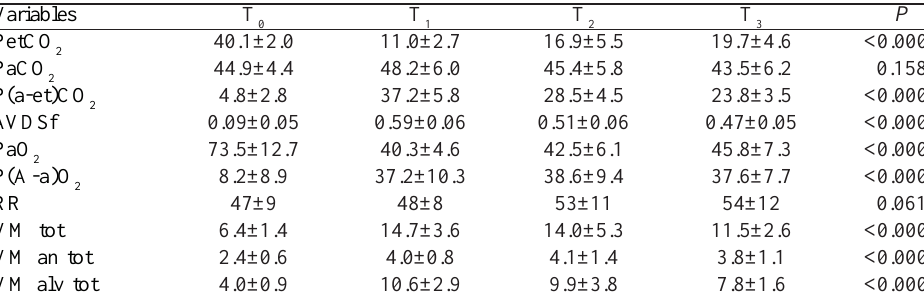
Table 1. Gasometric and capnographic